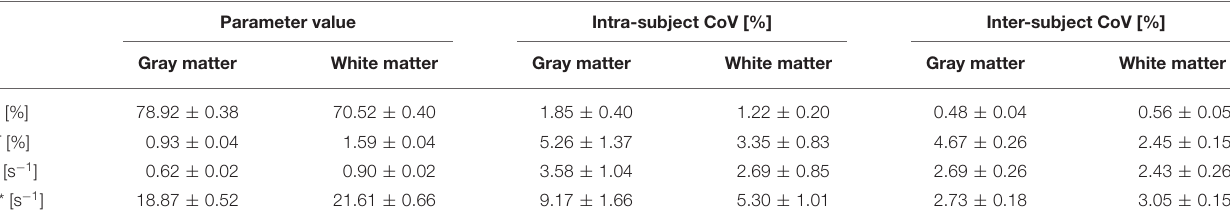
map and Gibb’s ringing correction. +